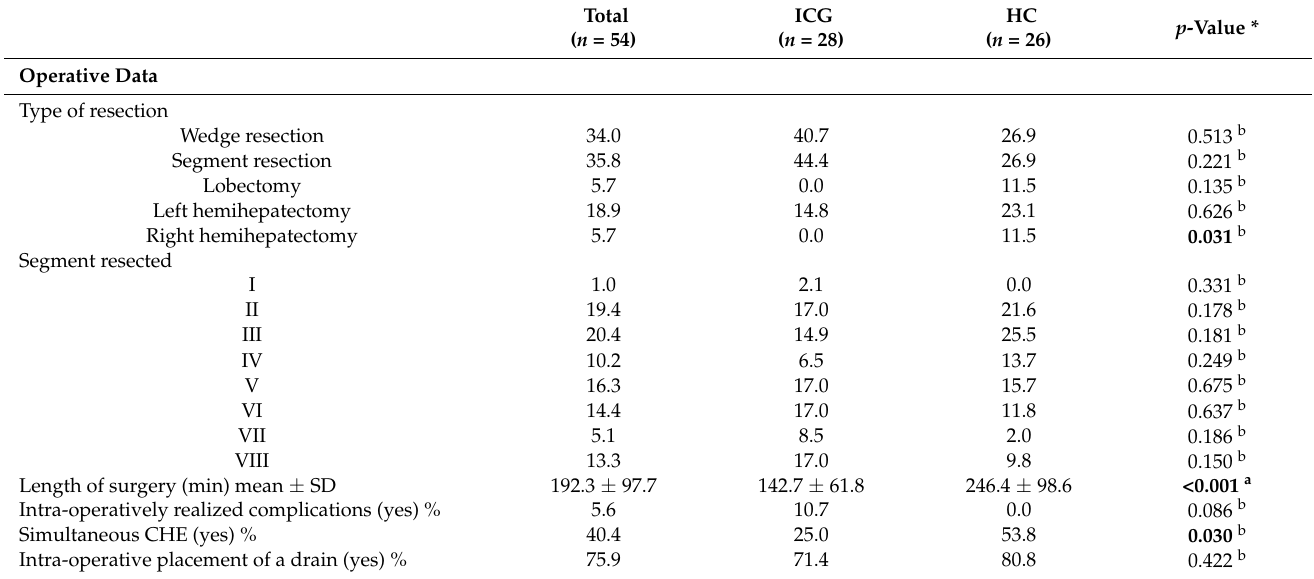
Table 3. Operative data of the comparison of patients who underwent RALS with and without obtaining preoperative intravenous